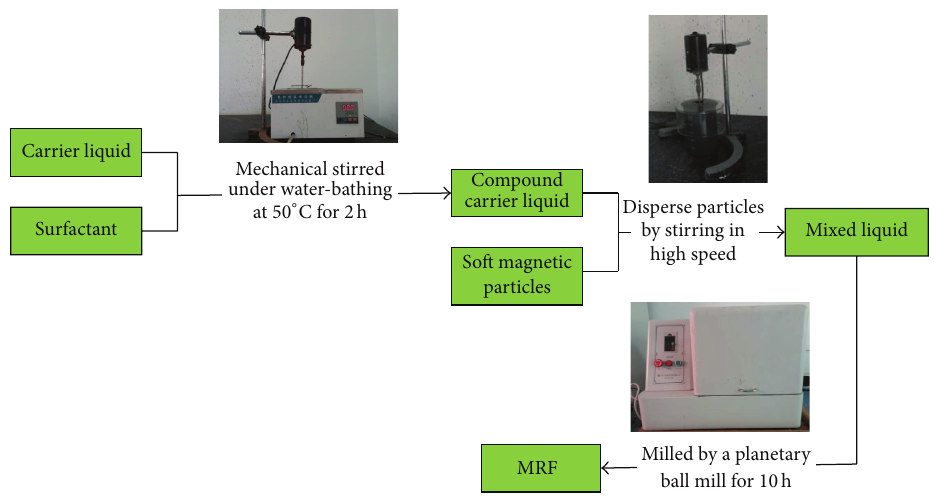
Figure 2: The preparation process of MRF.